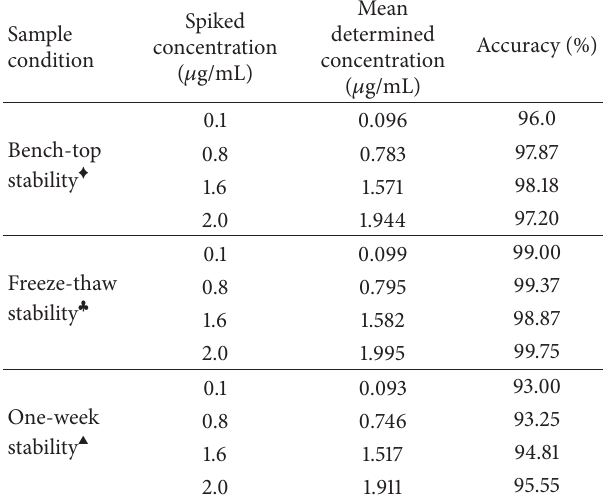
After three freeze-thaw cycles. 󳵳 Stored at − 16 ∘ C. Table 6: Pharmacokinetic parameters of free emtricitabine and emtricitabine NPs at a dose of